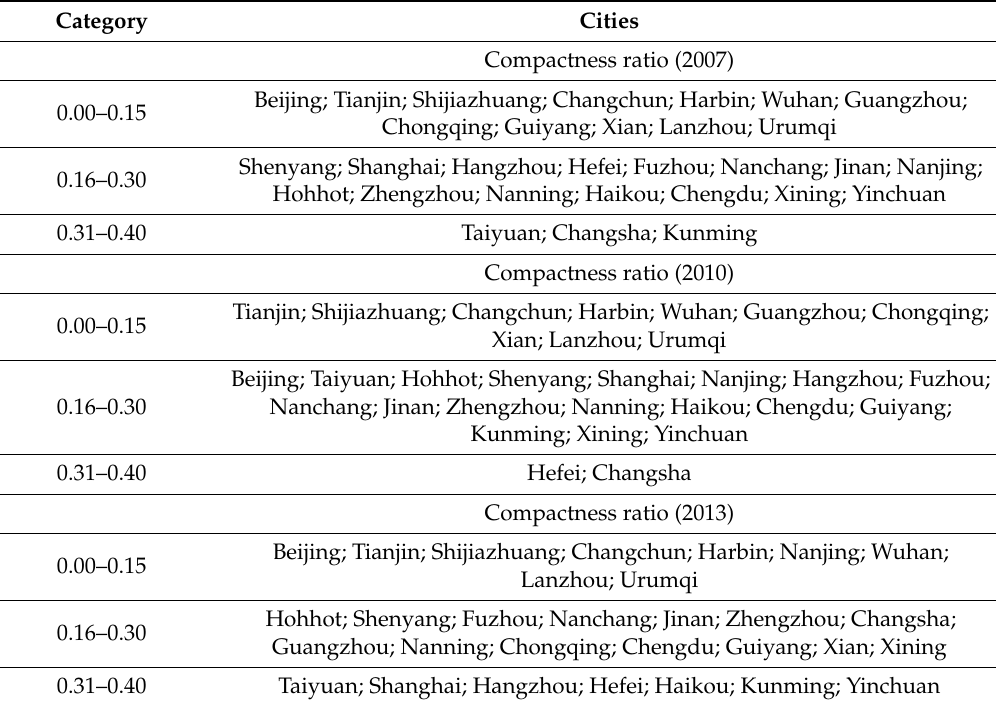
Table 6. Urban form descriptors for 30 Chinese cities during the years 2007, 2010 and 2013.